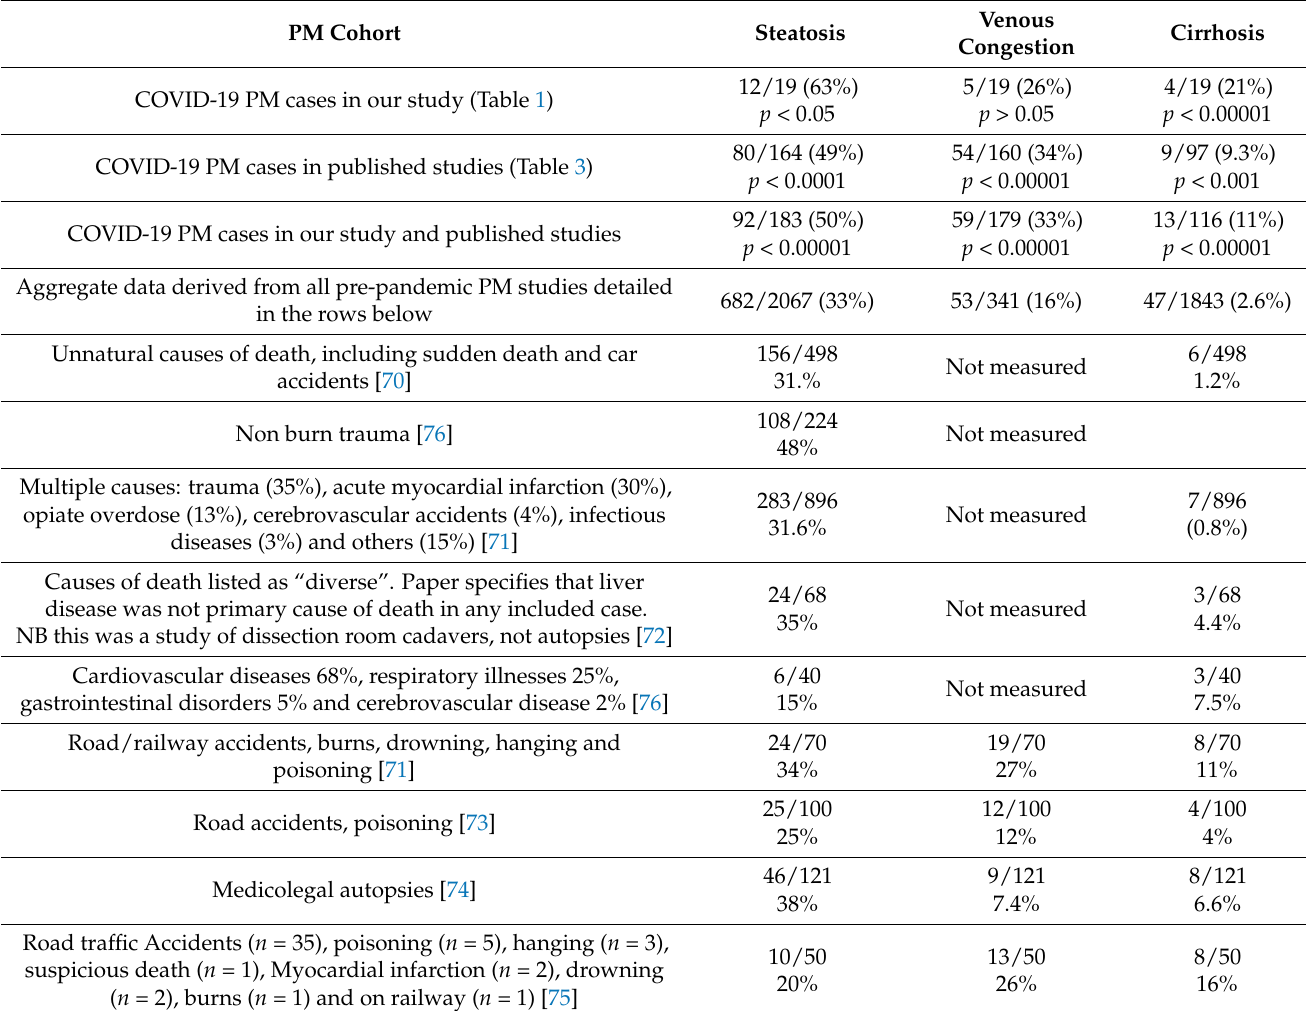
Table 4. Prevalence of steatosis, venous congestion and cirrhosis in pre-pandemic and COVID-19 post-mortem co- horts. Compared with pre-pandemic PM cohorts, our COVID-19 PM cohort had a significantly higher frequency of steatosis [X 2 (1, n = 2086) =7.72 p < 0.005] and cirrhosis [X 2 (1, n = 1862) = 24.22 p < 0.001], but not venous